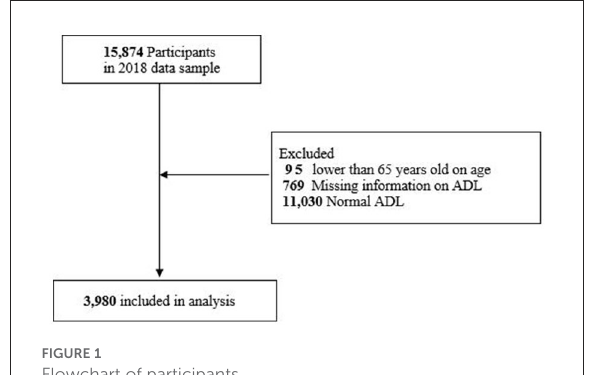
FIGURE1 Flowchart of